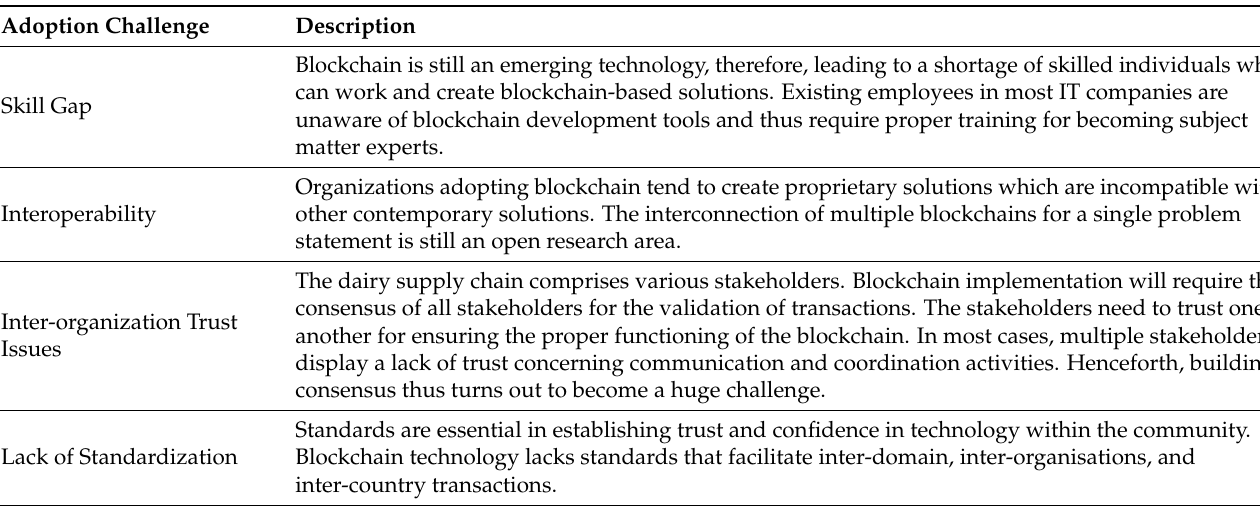
Table 6. Blockchain Adoption Challenges for Dairy Supply Chain